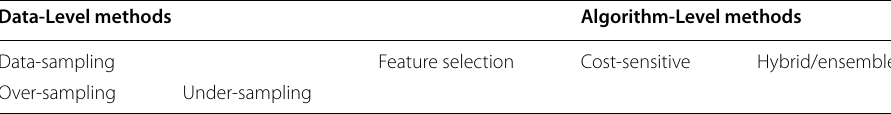
Table 1 Categories of methods addressing class